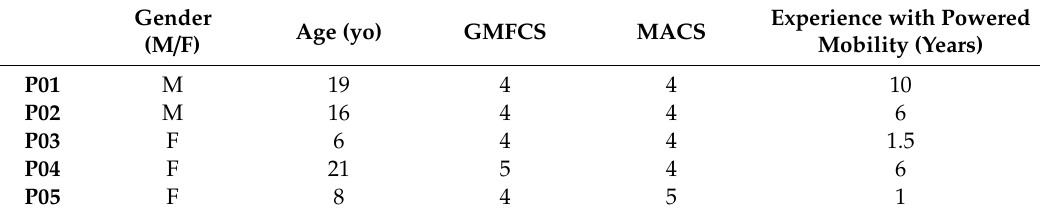
Table 1. Participants’ characteristics. Figure A1. Diagram of the Dyskinesia Impairment Scale (DIS) protocol. Figure 1. Diagram of the Dyskinesia Impairment Scale (DIS) protocol.